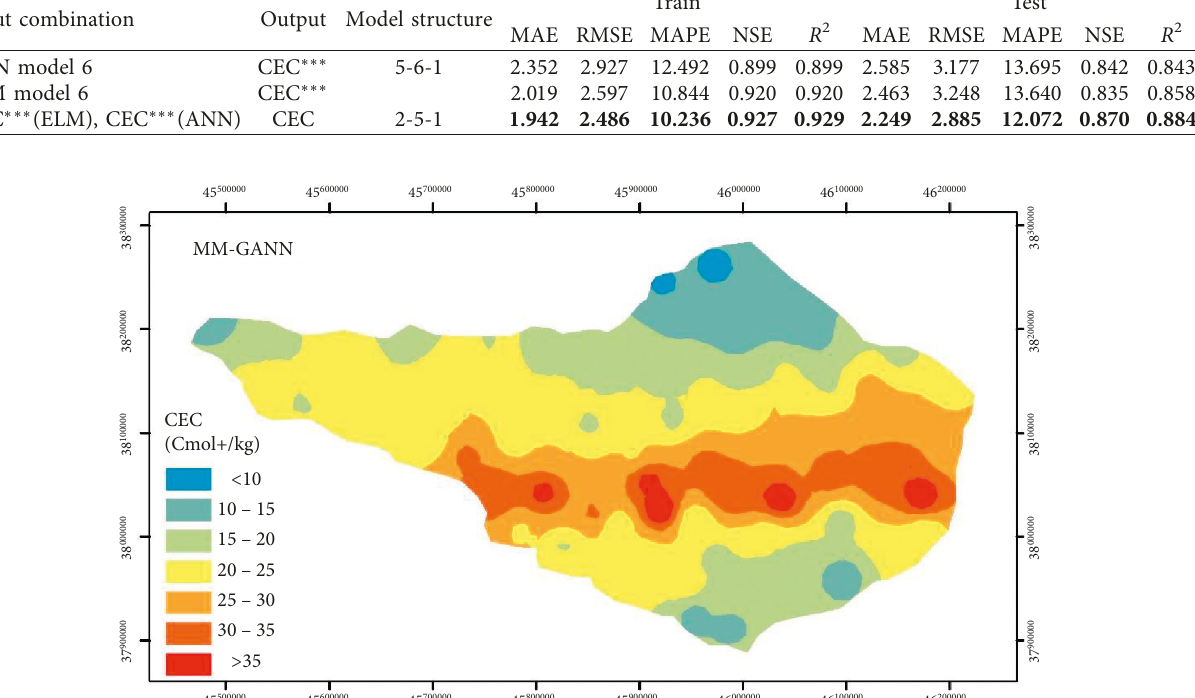
Figure 10: The spatial distribution map of MM-GANN predicted soil CEC (MM-GANN model calibrated with CEC ∗∗∗ (ELM) and CEC ∗∗∗ (ANN) as inputs).